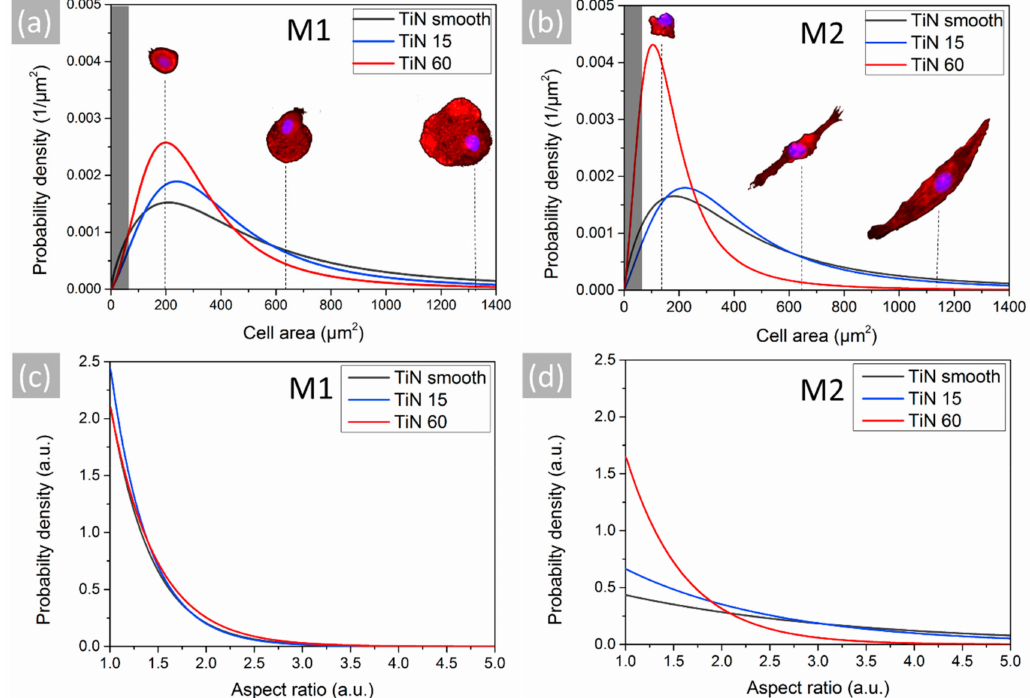
Figure 7. Statistical analysis of cell morphology. Probability density of ( a , b ) cell area and ( c , d ) aspect ratio for the M1- and M2-polarized macrophages on smooth and nanorough TiN surfaces obtained from fluorescence microscopy images. Data were merged for all three donors. Images of cells typically found at a size indicated by the dashed lines are inserted into the graphs to facilitate conceivability. The darkened parts in graph A and B indicate the range of cell size where no cells could be